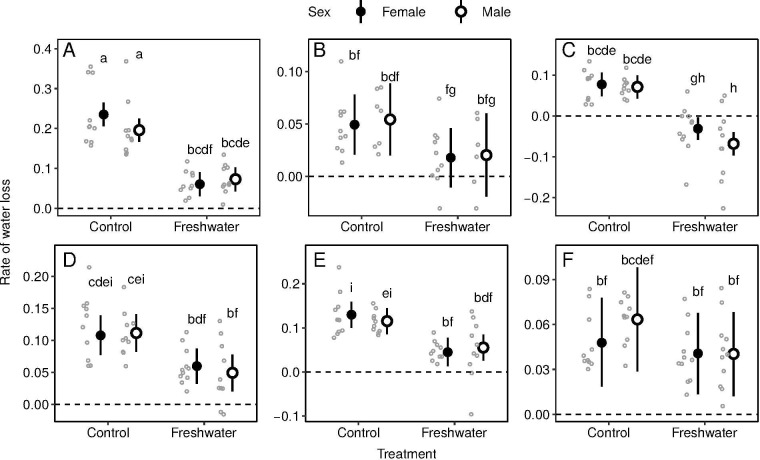
Rates of total water loss (RTWLs) in six lizard species, P. elegans (A), E. longicaudata (B), D. swinhonis (C), H. frenatus (D), A. sagrei (E), and E. multifasciata (F) in Taiwan. Circles and vertical bars present the posterior mean and 95% credible intervals on RTWLs, respectively. Alphabet letters above bars presents the results of post hoc comparisons; two groups sharing same letter(s) indicate no significant difference.